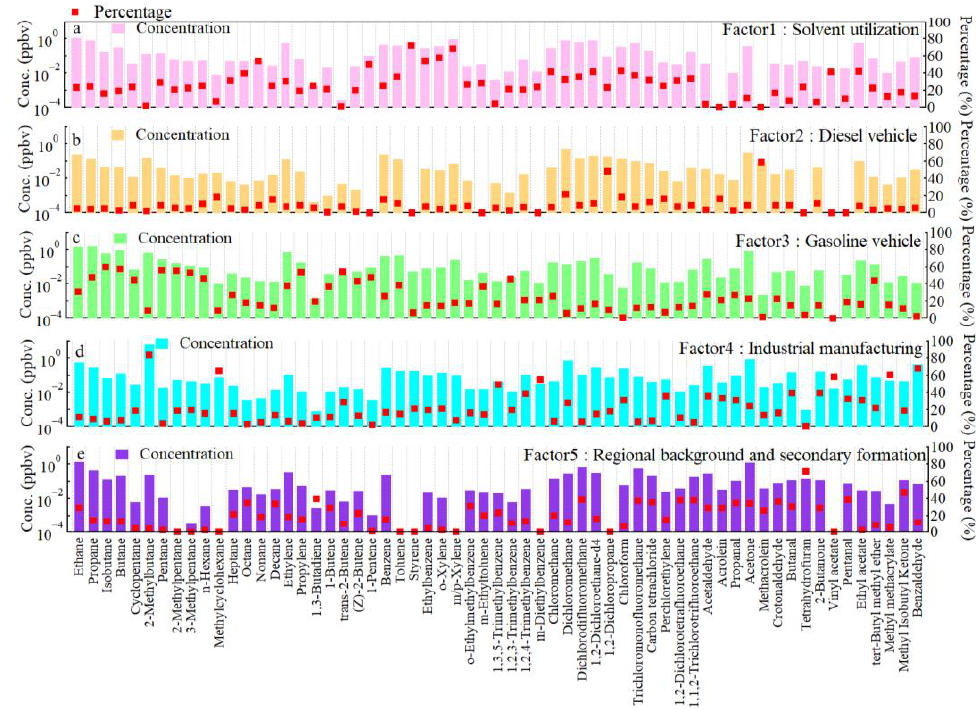
Figure 6. Source profiles of VOCs resolved from PMF in spring.